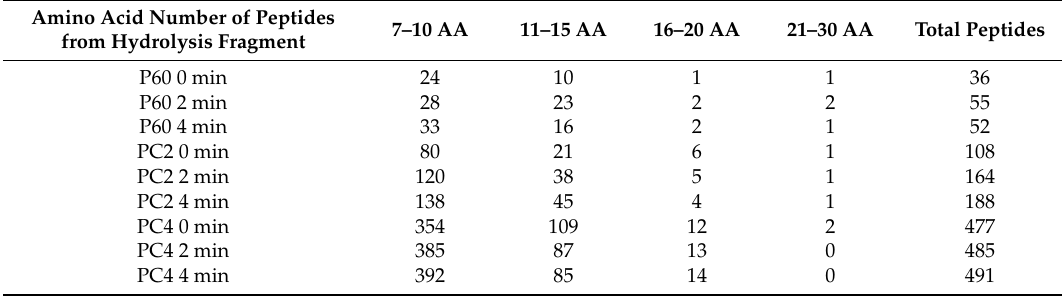
Table 1. Effects of ball-milling time (0, 2, and 4 min) on the number and length of peptides from hydrolysis fragment after simulated gastro duodenal digestion of